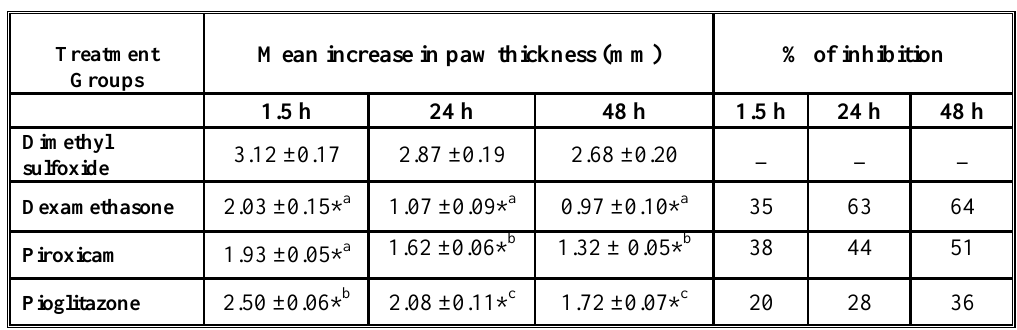
Table 2. Effect of pioglitazone on formalin-induced sub-acute inflammation in